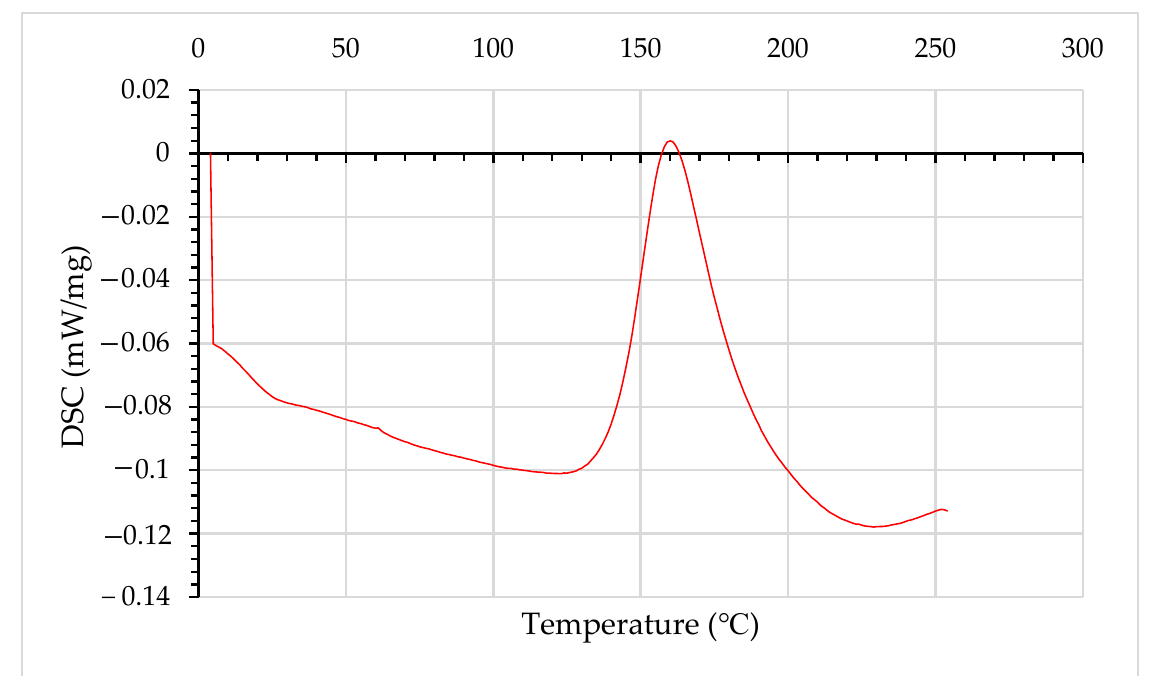
C = Carbon Fibre; G = Glass Fibre; T = Veil Interlayering.